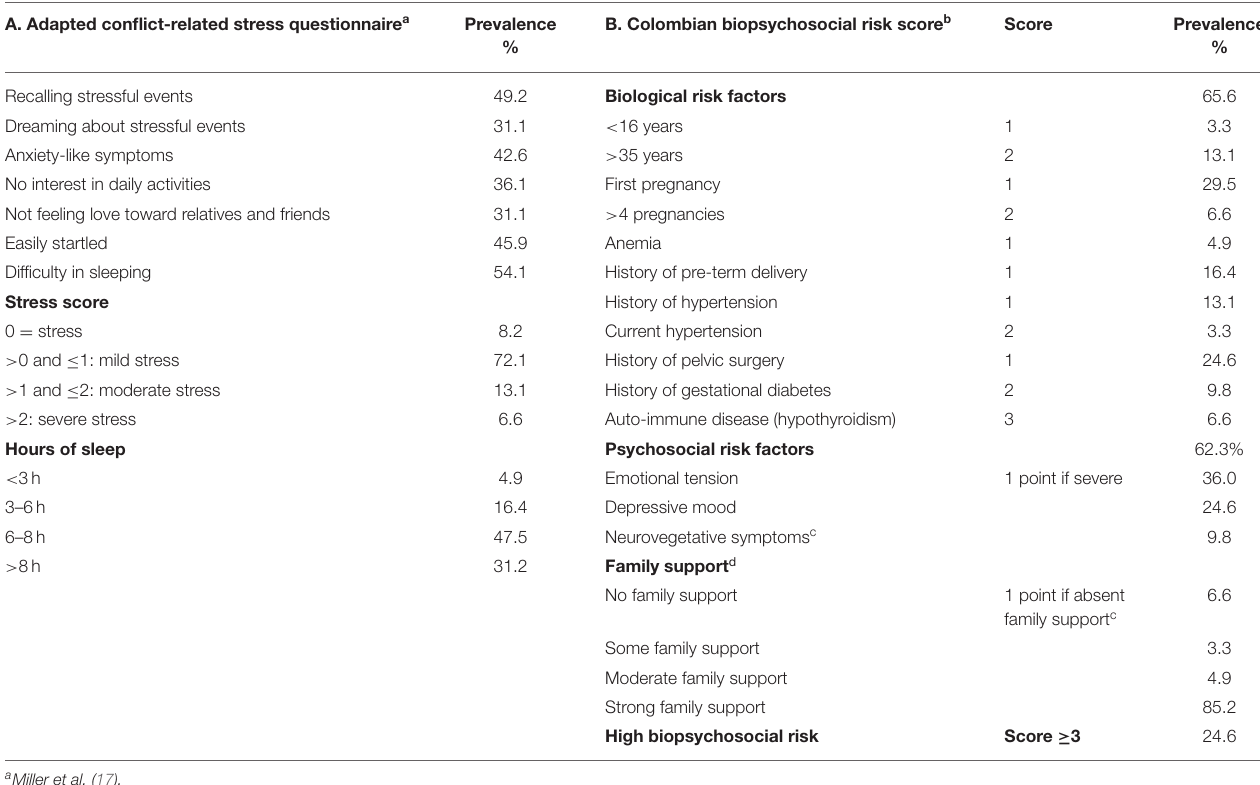
TABLE 3 | Items and scores for (A) Adapted conflict-related stress and (B) Colombian biopsychosocial risk assessment.